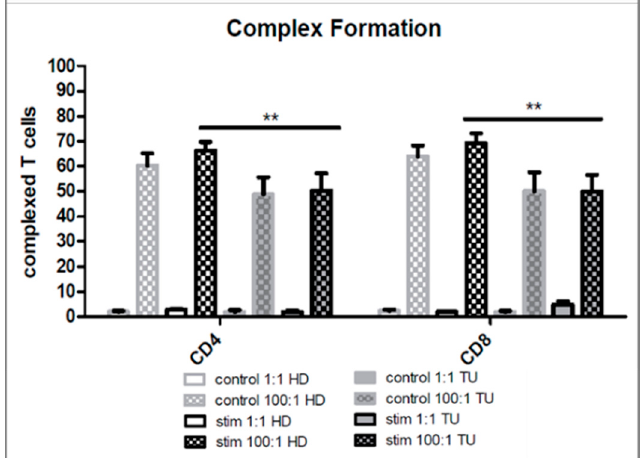
Figure 2. A ggregate Formation of platelets and T cells analyzed by flow cytometry. Percentage of complexed (CD41+) CD4+ or CD8+ T cells in unstimulated or CD3/CD28 stimulated samples from healthy donors (HD) and HNSCC patients (TU) after 24 h. Bars show mean + SEM of results from 20 healthy donors or 7 HNSCC patients. ** p ≤ 0.01; two-tailed paired Students’s t -test.